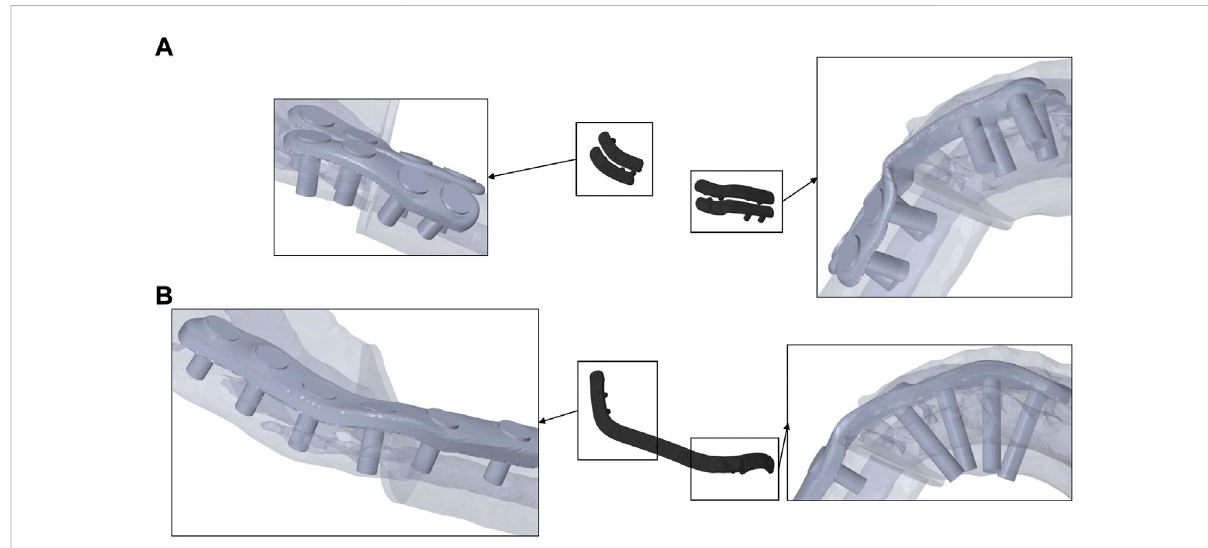
FIGURE 2 Miniplates (A) , fi xed monocortically in the mesial and bicortically in the distal healing site, and reconstruction plate (B) , fi xed bicortically in both healing sites, on transparent mandible from a caudal